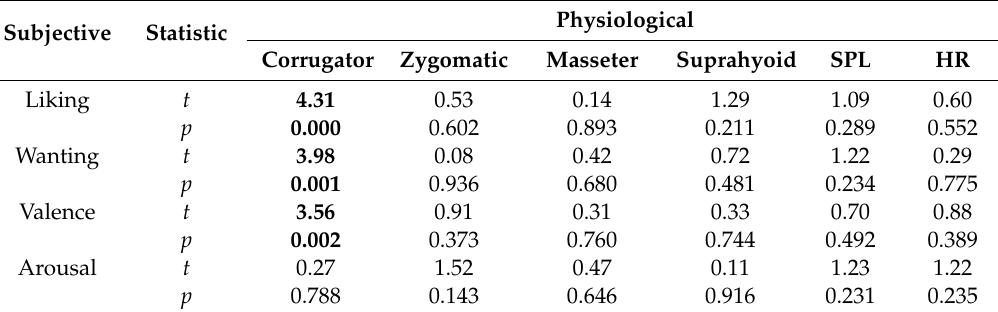
Figure 3. Mean (with standard error) intraindividual correlation coe ffi cients between subjective ratings and physiological responses across stimuli: Corrugator = corrugator supercilii; Zygomatic = zygomatic major; SPL = skin potential level; HR = heart rate. ***, p < 0.001; **, p < 0.005. Table 1. Results of one-sample t -test (two-tailed) for intraindividual correlation coe ffi cients between subjective ratings and physiological responses.